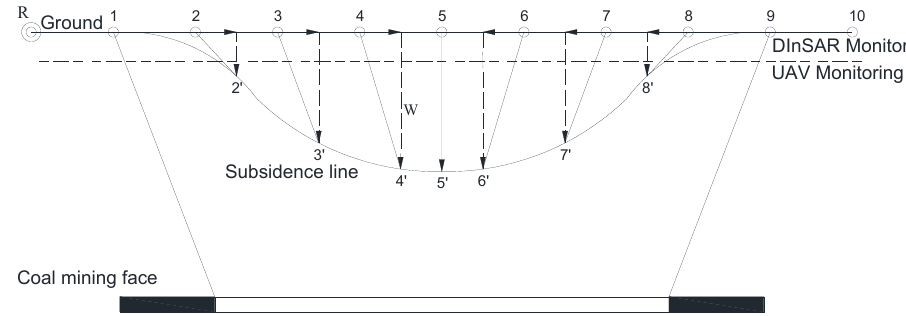
Figure 7. Surface movement basin graph.